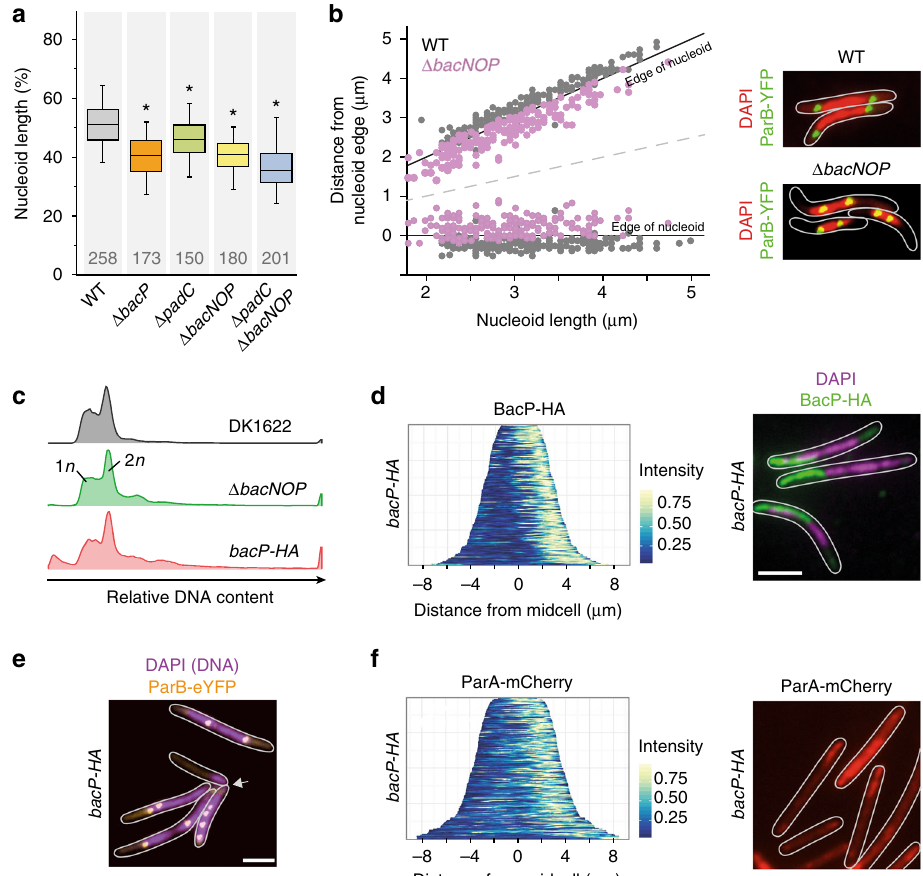
Fig. 7 The BacNOP · PadC complex functions in nucleoid organization and DNA segregation. a Shortening of the nucleoids in the absence of bacto fi lins or PadC. Strains DK1622 (WT), LL001 ( Δ bacP ), LL101 ( Δ padC ), MT295 ( Δ bacNOP ), and LL174 ( Δ bacNOP Δ padC ) were stained with DAPI and analyzed by DIC and fl uorescence microscopy. Shown is the length of the nucleoid along the longitudinal axis of the cell normalized to cell length. Values are represented as box plots (de fi ned in the legend to Fig. 2e and f). The number of cells analyzed for each strain is given. Signi fi cant differences between the wild-type and mutant strains are indicated by asterisks ( p < 0.001; t- test). b Aberrant positioning of the chromosomal origin regions in the absence of BacNOP. Cells of strains LL012 (P parB - parB-eyfp ) and LL019 ( Δ bacNOP P parB - parB-eyfp ) were analyzed by fl uorescence microscopy to determine the positions of ParB-YFP foci relative to the edges of the nucleoid, as visualized by DAPI staining ( n = 179 cells for LL012 and 181 cells for LL019). Images of exemplary cells are given on the right. c Changes in DNA content upon mutation of bacto fi lin genes. Cells of strains DK1622 (WT), MT295 ( Δ bacNOP ), and LL032 ( bacP-HA ) were incubated with a fl uorescent DNA stain and subjected to fl ow cytometric analysis. Shown are histograms giving the distribution of fl uorescence intensities in the different cell populations ( n = 30,000 cells per strain). d Asymmetric subcellular distribution of BacP-HA. Cells of strain LL046 ( bacP-HA P parB - parB-eyfp ) were subjected to immuno fl uorescence microscopy with anti-HA antibodies and treated with DAPI to visualize the nucleoids. The population-wide distribution of the immuno fl uorescence signals was visualized by demographic analysis (on the left; n = 150 cells). An exemplary overlay of the immuno fl uorescence and DAPI signals is shown on the right (bar: 3 µ m). e Unequal distribution of chromosomal DNA and ParB · origin complexes in the presence of BacP-HA. Cells of strain LL046 were treated with DAPI and analyzed by fl uorescence microscopy (bar: 3 µ m). f Asymmetric subcellular distribution of ParA-mCherry in the presence of BacP-HA. Cells of strain LL150 ( bacP-HA P parA - parA-mCherry ) were imaged by fl uorescence microscopy. The population-wide distribution of the fl uorescence signals was visualized by demographic analysis (on the left; n = 116 cells). An exemplary fl uorescence image is given on the right (bar: 3 µ